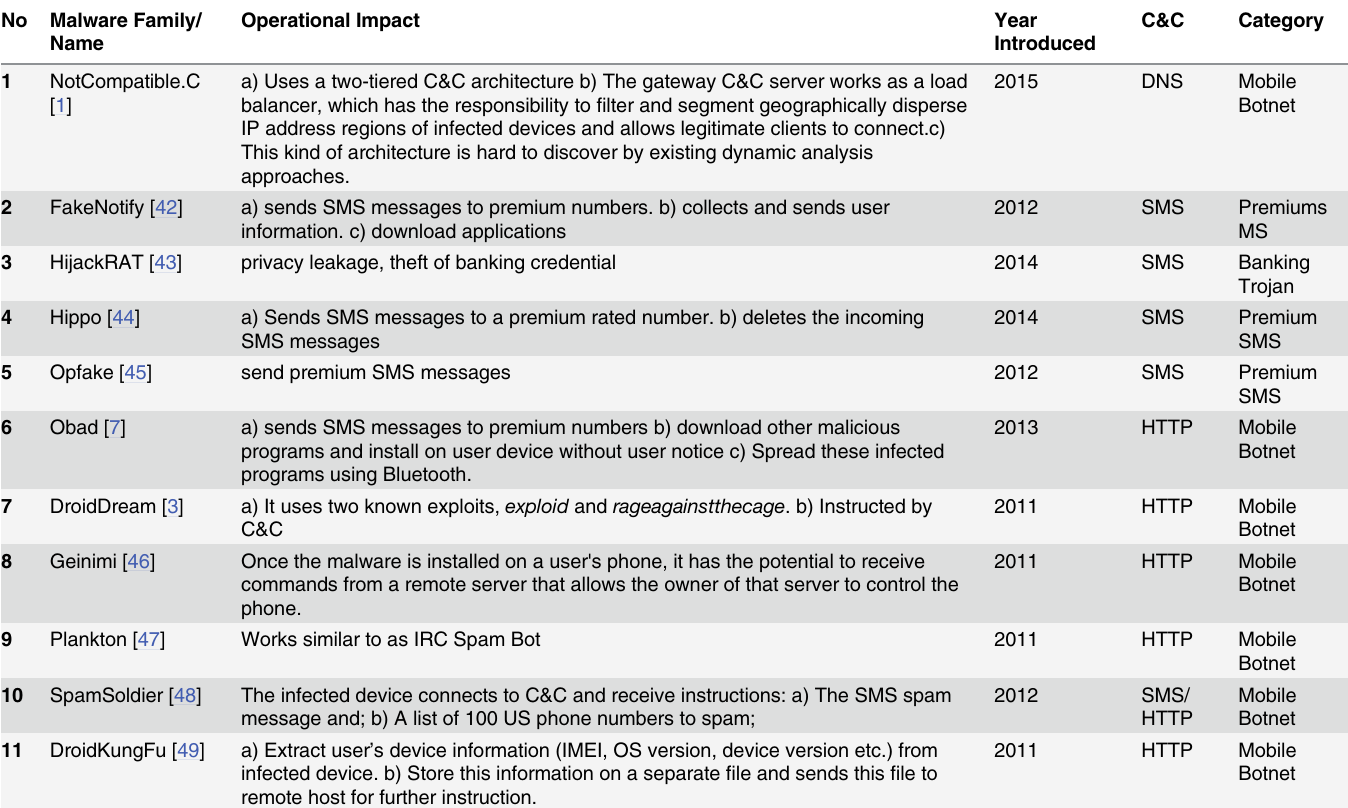
Table 2. Summary of Selected Sample Dataset.